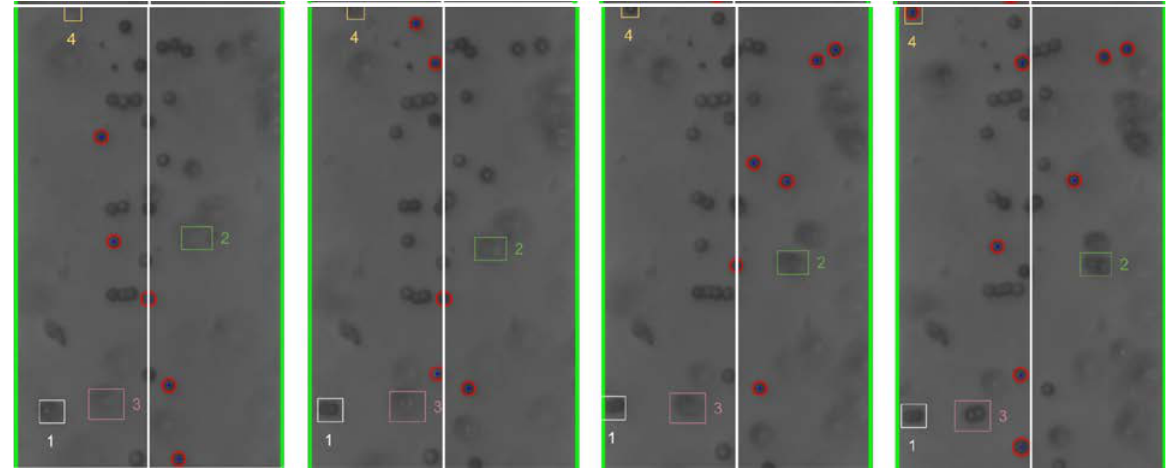
Figure 10. Individual bead movement during Trial 2 from frames 570 to 685. Figure 11. Individual bead movement during Trial 2 from frames 735 to